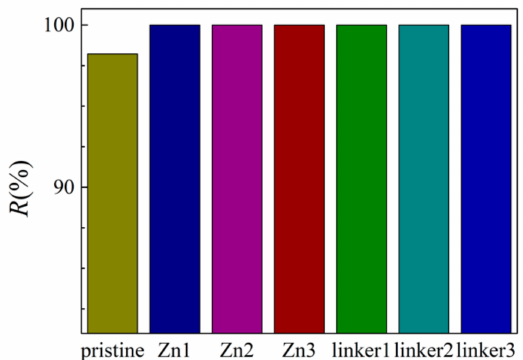
Figure 2. Salt rejection rate of the ZIF-8 membranes with different types and concentrations of substitutional defect